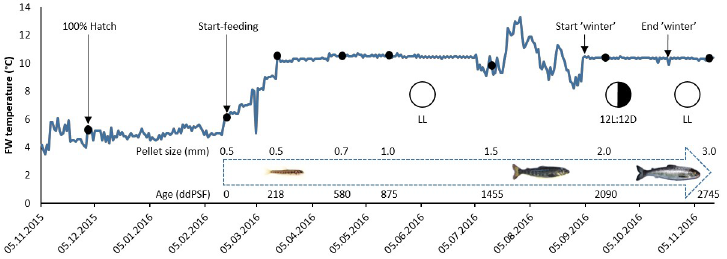
Fig 1. Overview of rearing conditions and main operations during the trial. Black dots indicate sampling points where 25 fish per tank were weighed and measured. Arrows indicate other events or operations. FW = freshwater; LL = constant light; 12L:12D = light regime used during ‘winter’ stimulation. Pellet size (mm) employed over the whole trial and fish age in degree-days post start-feeding (ddPSF) at each sampling point (0–2745 ddPSF) are shown. Figure adapted from